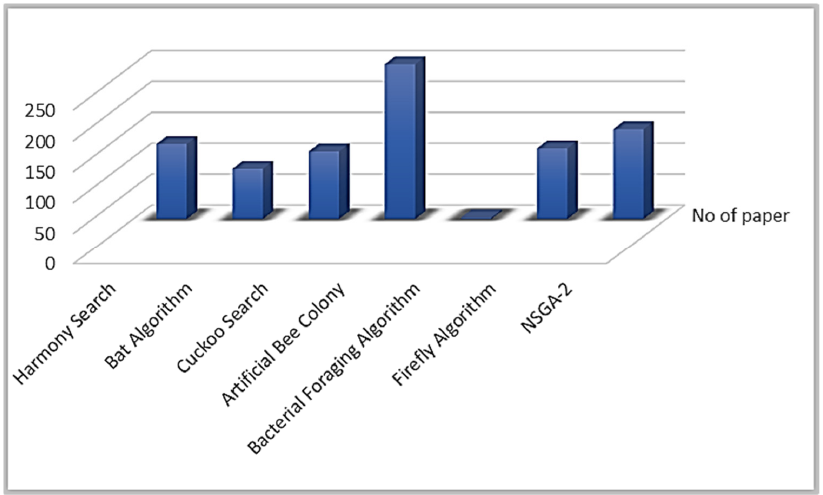
Figure 5. No of papers with relative metaheuristic technique used in combinatorial optimization (Web of Science Database).